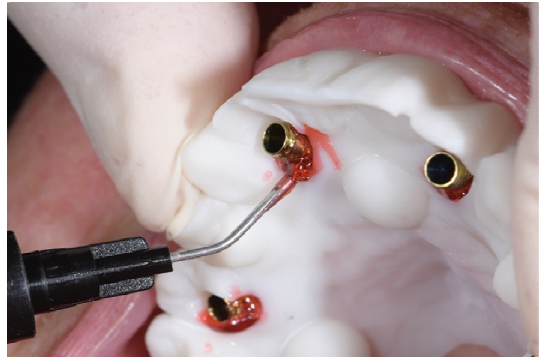
Figure 19. Prototype aesthetic try-in, used for the aesthetic and functional tests.